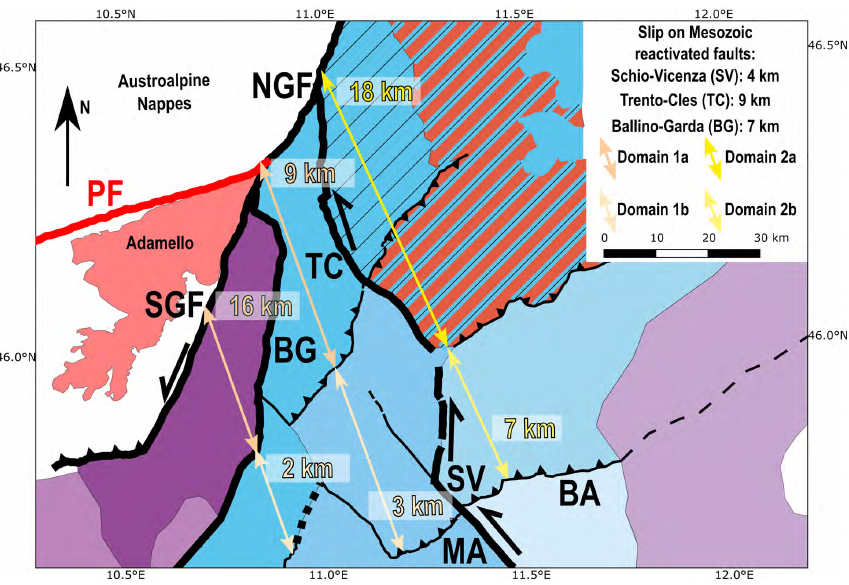
Figure 11. Lateral variation of shortening coinciding with paleogeographic zones (Fig. 2), bounded by Mesozoic faults (BG, SV, TC) that were reactivated as Neogene strike-slip faults. The TC-SV fault system accommodated the largest variation of shortening and subdivides the area into two kinematic domains west and east thereof, domain (1) and (2), respectively. Each profile is furthermore subdivided into a northern and southern segment based on the age of deformation, with the northern domains indicating older deformation of the Giudicarie or Valsugana phase, and southern domains showing a younger, active phase of shortening along the Southern Alpine orogenic front (labelled as the Marana (MA) and Bassano Faults (BA); see Fig. 12). See Fig. 1 for fault